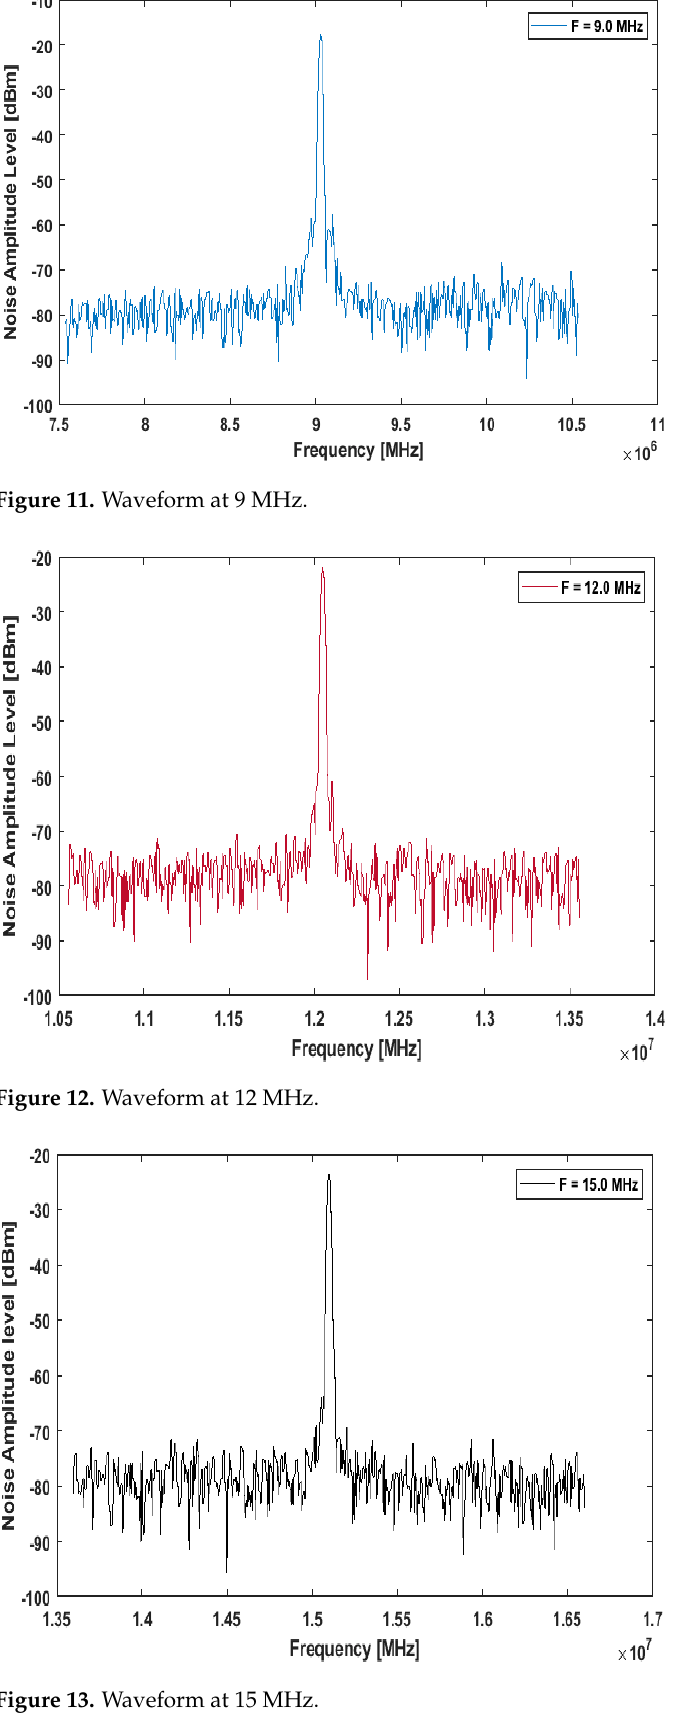
Figure 13. Waveform at 15 MHz.